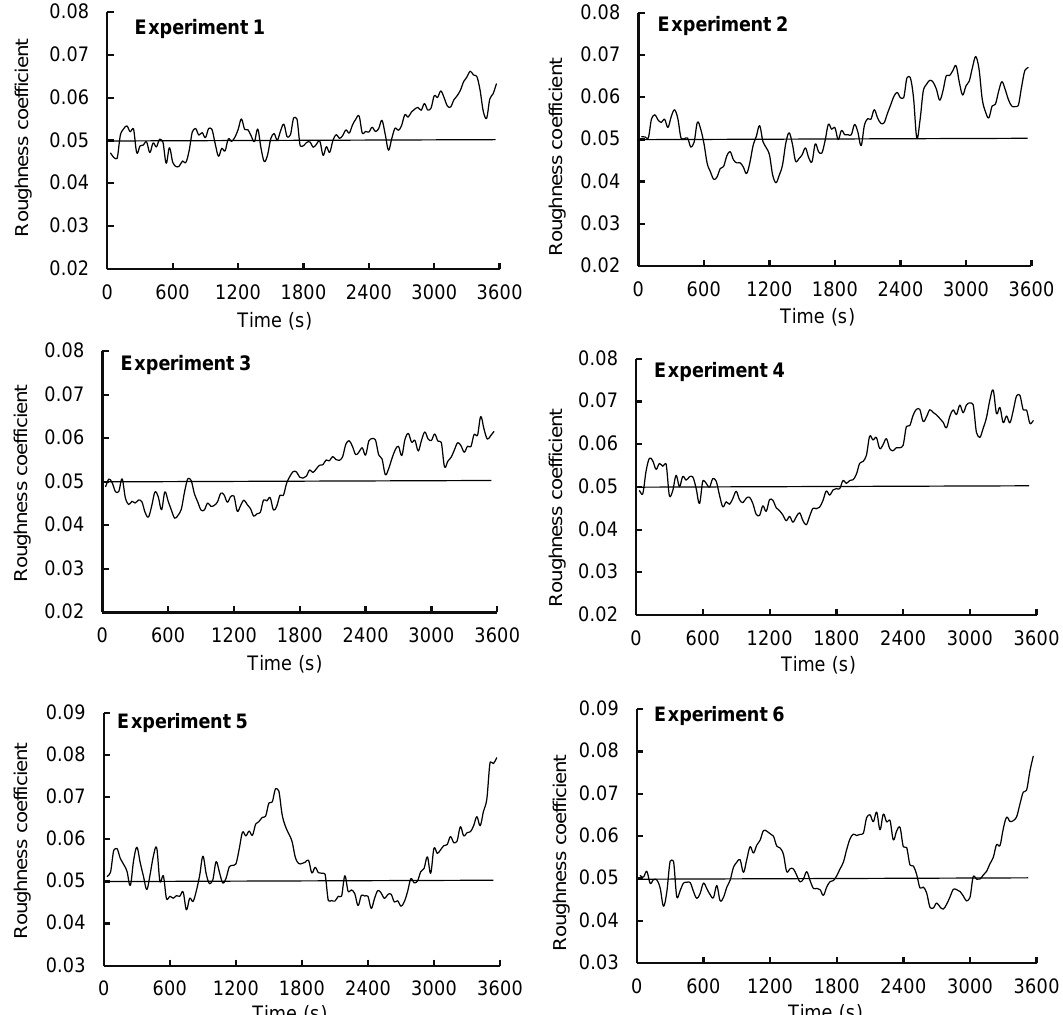
Figure 6. Dynamic variation process of roughness. The straight line indicates the fixed value used in the hydrodynamic